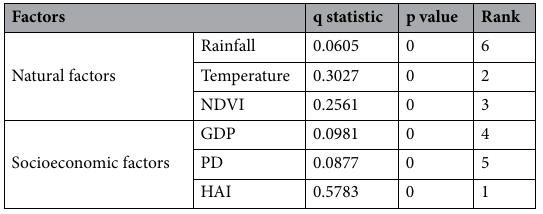
Table 5. Factor detection for spatial heterogeneity of carbon storage.